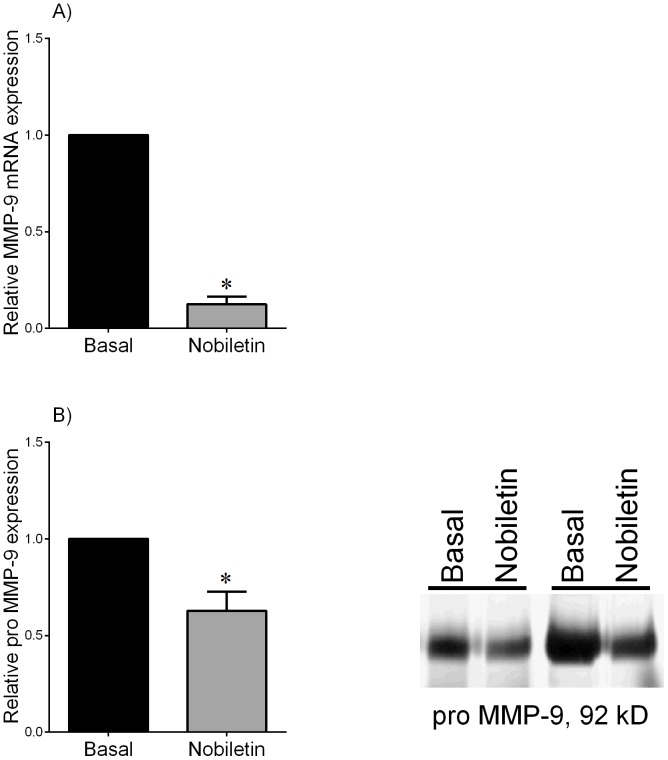
Effect of nobiletin on MMP-9 expression in preterm fetal membranes.Preterm fetal membranes with histological chorioamnionitis and following spontaneous preterm labour were incubated for 20 h with or without 200 µM nobiletin (n = 9 patients). (A) MMP-9 mRNA expression was analysed by qRT-PCR and normalised to GAPDH mRNA expression. The fold change was calculated relative to basal expression, which was set at 1. Data is displayed as mean ± SEM (one-way ANOVA). *P<0.05 vs. basal expression. (B) The incubation medium was assayed for for pro MMP-9 levels by gelatin zymography. Data was normalised to untreated (basal) levels, which was set at 1. Each bar represents mean ± SEM (one-way ANOVA). *P<0.05 vs. basal release. Zymography from two patients is also shown.